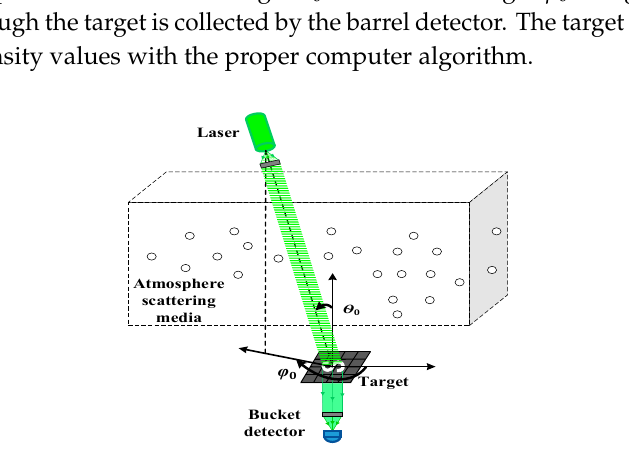
Figure1. Figure 1. Compressive sensing (CS) imaging model based on modulation of atmospheric scattering medium.